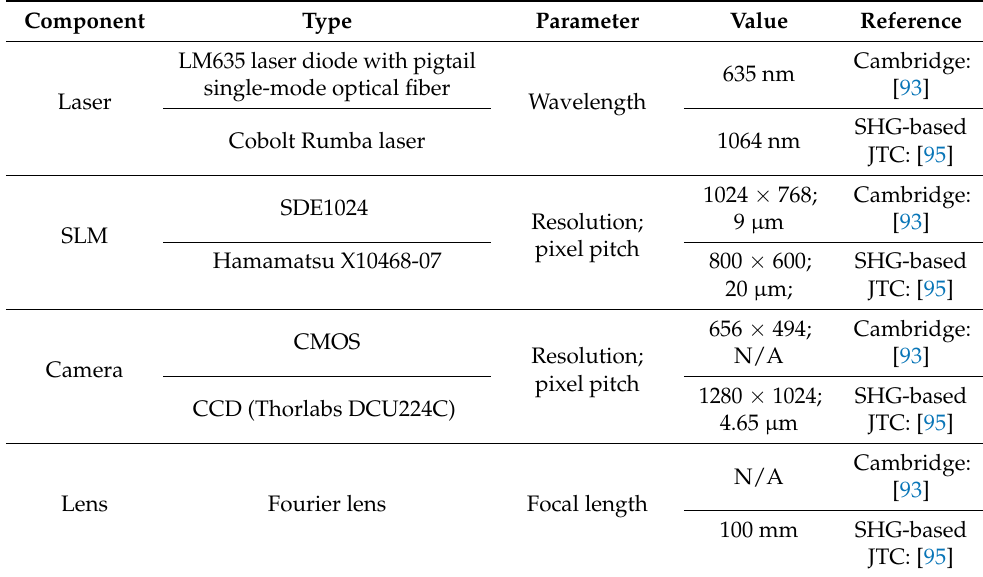
Table 3. Comparison between the most important parameters of the JTC setup in various proposed architectures, in applications of image